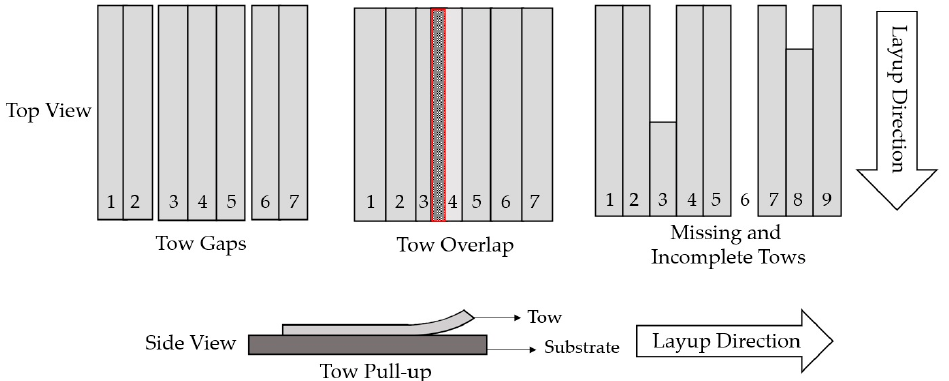
Figure 1. Commonly found defects in the AFP process.